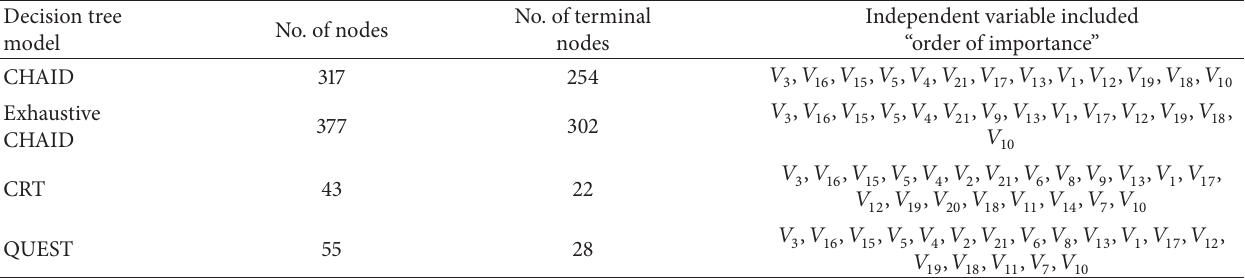
Table 1: Number of nodes, terminal nodes, and order of importance